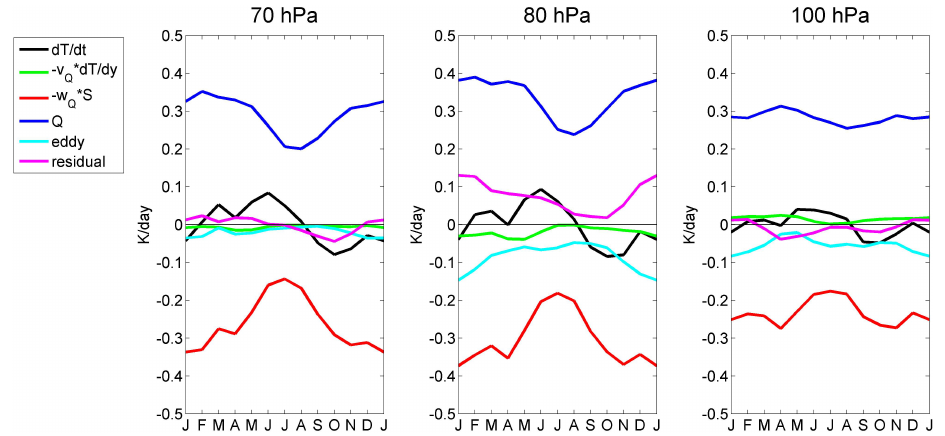
Fig. 5. Mean seasonal cycle (monthly means for the period 2005-2010) of the terms in the thermodynamic equation (Eq. 4) averaged over 18 ◦ N–S for the three pressure levels indicated. The residual is defined as the difference between the tendency and the sum of all the explicitly evaluated terms (Kday − 1